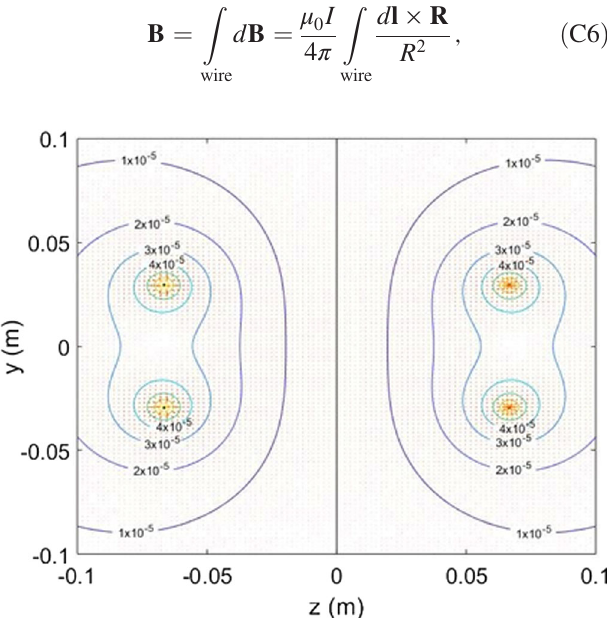
component of the magnetic flux density on the z - y y